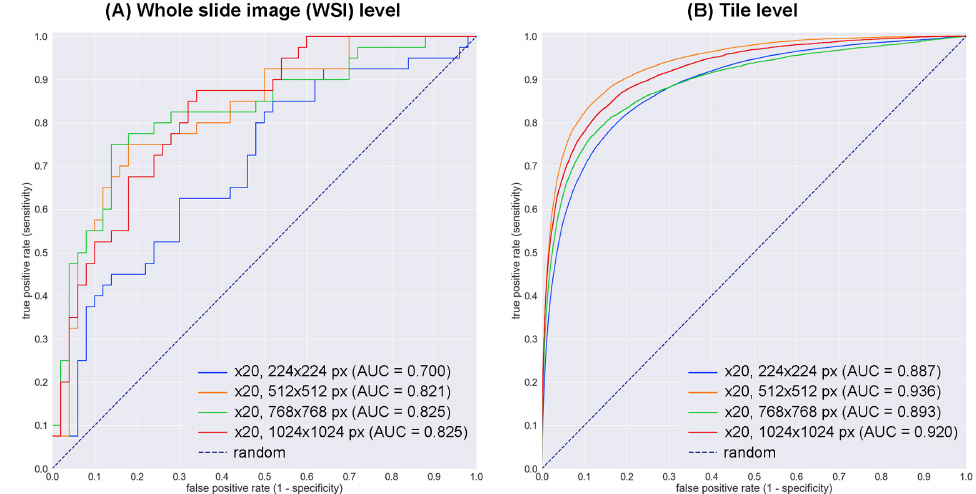
Figure 2. ROC curves for the test set using four trained deep learning models at the whole-slide image (WSI) level and tile-level evaluations. At the WSI level evaluation ( A ), the models ([ × 20, 512 × 512 px], [ × 20, 768 × 768 px], and [ × 20, 1024 × 1024 px]) showed near-equivalent area under the curve (AUC) scores, which reached 0.821–0.825. With the tile-level evaluation ( B ), the model ( × 20, 512 × 512 px) exhibited the highest AUC score